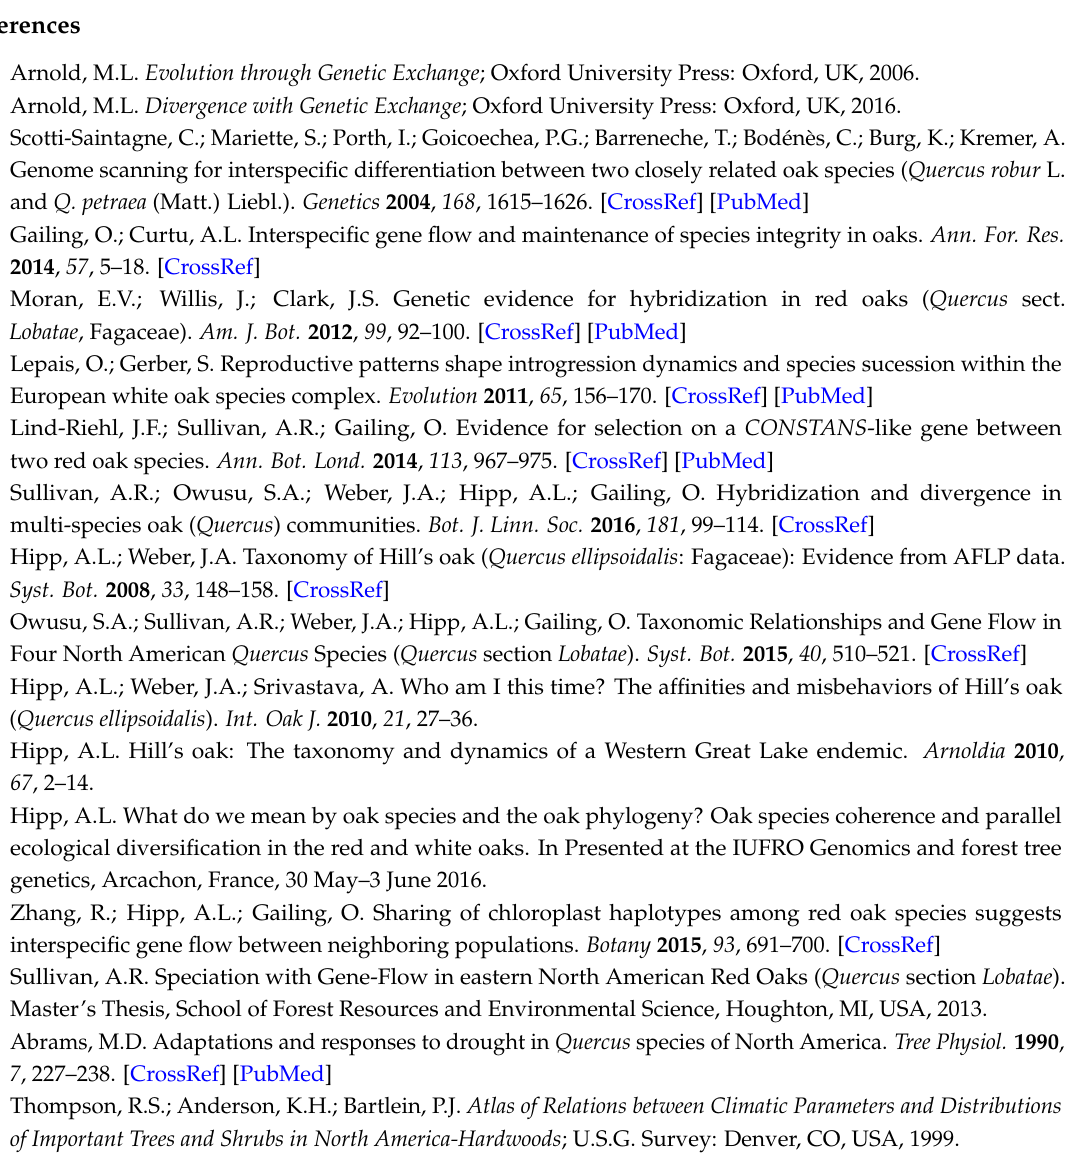
FDR, Table S1: Location of collection sites for the 16 Quercus spp. populations, Table S2: Microsatellite marker characteristics, Table S3: Characteristics of samples used in the sequencing effort, Table S4: Relative frequency of a single nucleotide polymorphism in the coding region of a COL gene (Position 9, see Figure 2), Table S5: Genetic variation parameters by population and species across the 12 microsatellite markers, Table S6: Genetic variation parameters by population and species across 11 non-outlier microsatellite markers, Table S7: Pairwise F ST value by species across all 12 microsatellite markers using GeneAlEx [6], Table S8: F ST -based outlier screening results across the 12 microsatellite markers using LOSITAN